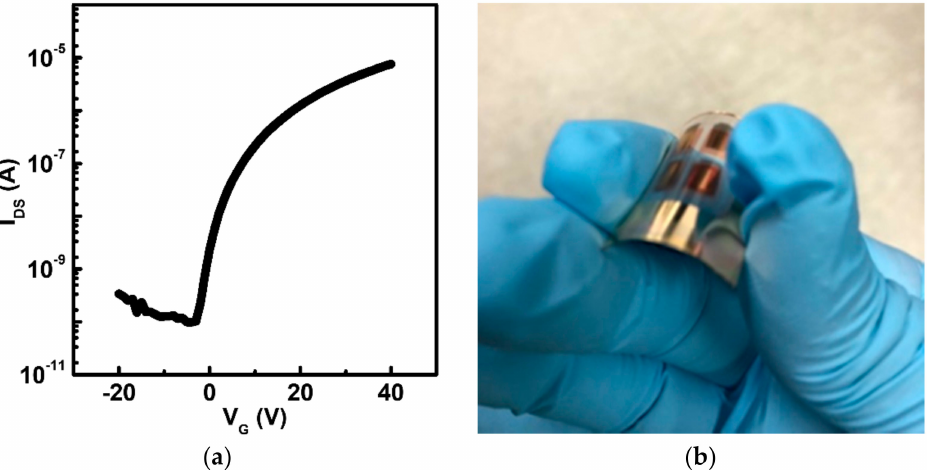
Figure 5. OTFT devices fabricated on flexible PEN substrates. ( a ) Transfer characteristics using a PTCDI-C13 as semiconductor (channel width and length are 2000 and 50 µ m, respectively); ( b ) Photo of flexible OTFT